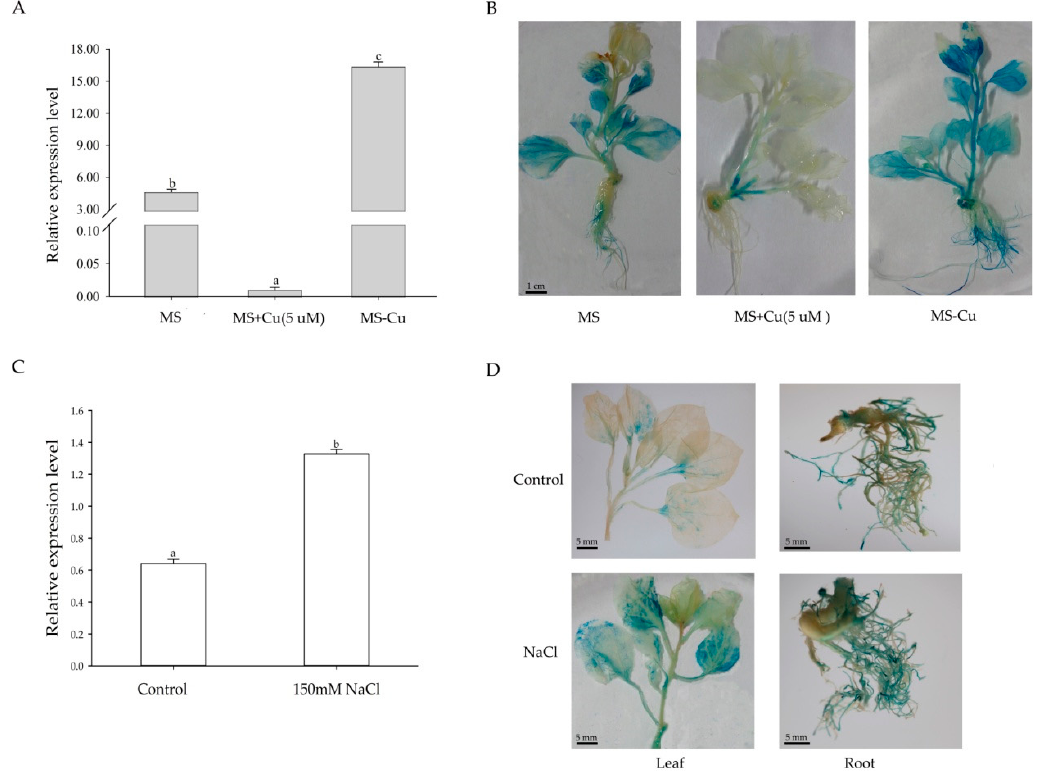
Figure 1. Transcription of Sm-MIR408 is induced under deficient copper conditions or NaCl treatment. ( A ) Expression level of Sm-MIR408 when two-week-old S. miltiorrhiza seedlings were transferred to standard Murashige and Skoog (MS) medium (0.1 µ M copper), MS medium deficient in copper (0 µ M, MS − Cu) and sufficient copper (5 µ M, MS+Cu) for 7 days. ( B ) β -glucuronidase (GUS) staining results when one-week-old transgenic Nicotiana benthamiana expressing MIR408pro::GUS were transferred to MS, MS − Cu and MS+Cu for three weeks. ( C ) Expression levels of Sm-MIR408 in one-month-old Salvia miltiorrhiza seedlings treated with 150 mM NaCl for 24 h. ( D ) The GUS staining in the transgenic Nicotiana benthamiana expressing MIR408pro::GUS after treatment with 150 mM NaCl. For RT-qPCR, all data are means of three biological replicates, with error bars indicating SD; significant differences were determined using Duncan’s multiple range test (indicated by different letters at p <